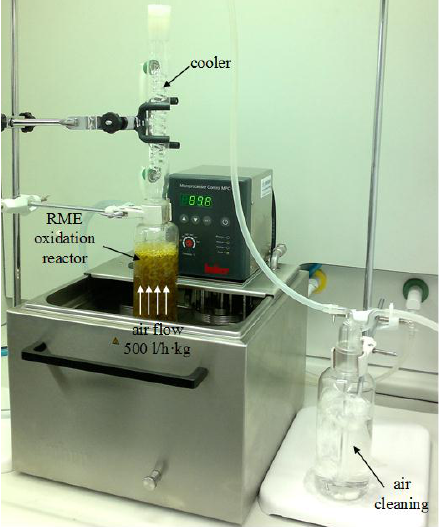
Figure 1. Laboratory setup for bio-agent production: reactor for oxidation of rapeseed oil esters.